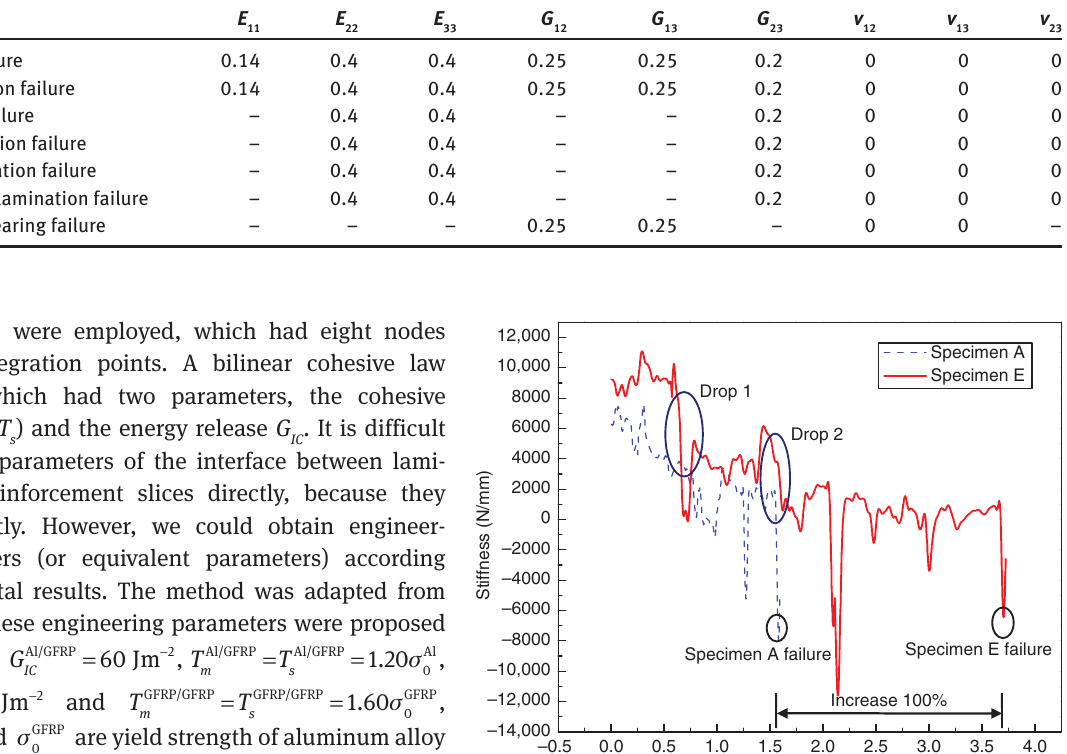
between the laminates and the bolt washer. The friction coefficient was specified as 0.114 [14]. Forces along the normal plane were applied on the bolt to simulate